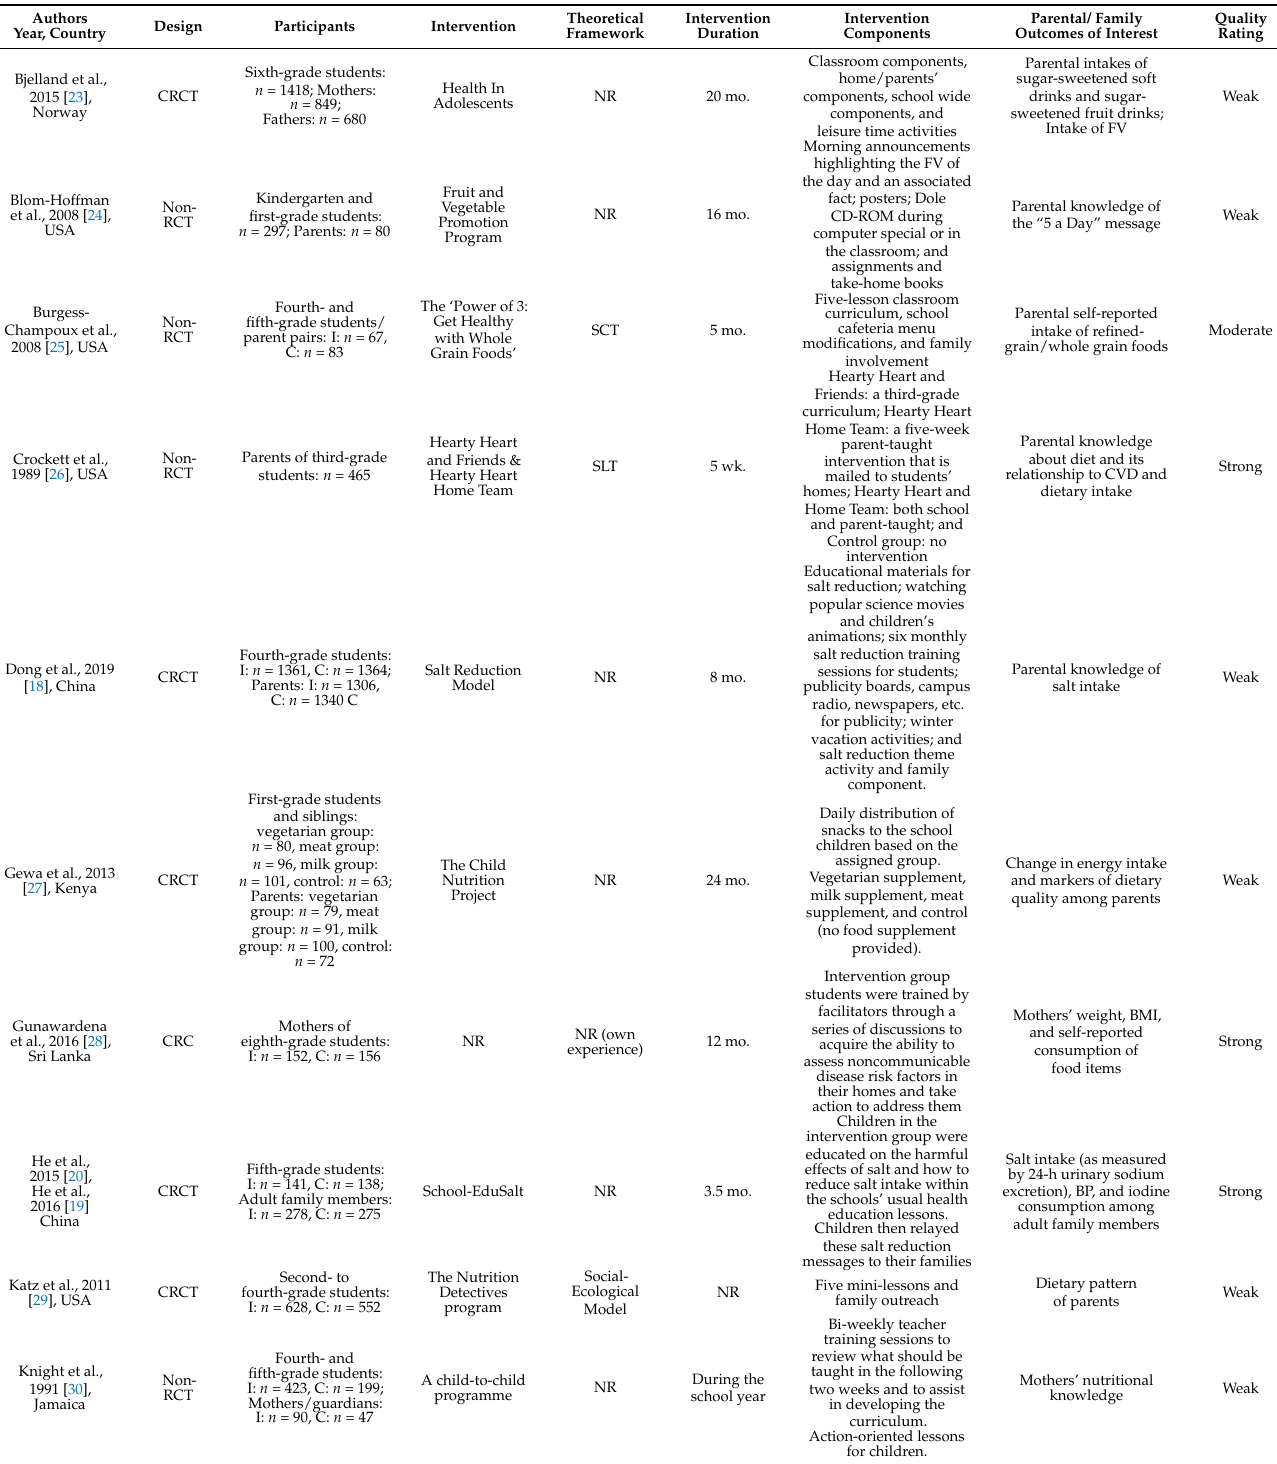
Table 1. General characteristics and quality ratings of included studies.